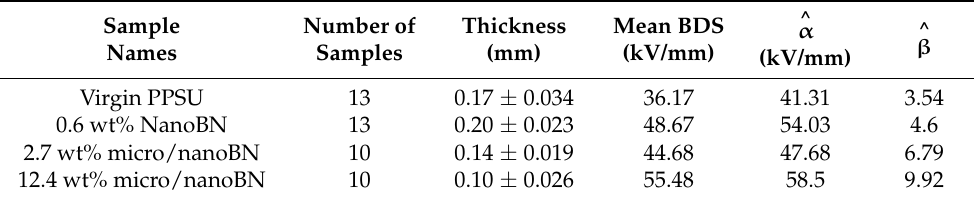
Table 1. This table shows the sample names with h-BN weight percent, the sample thickness in millimeters, the mean voltage breakdown strength (BDS), the Weibull scale parameter α , the Weibull shape parameter β . The ^ indicates the weighted estimations of α and β .